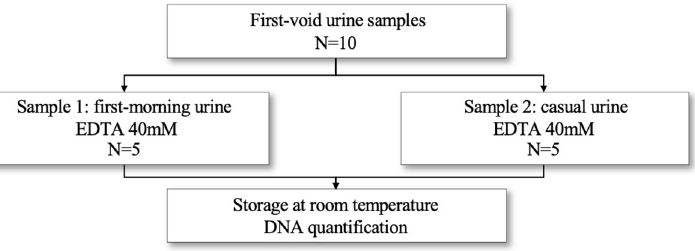
Fig 3. Overview of sample collection and processing for the third evaluation. Two samples were collected from each of the five participants, one from a first-morning micturition and a second one at a convenient time of the day which differed between women and was not prespecified. Samples were then stored at room temperature until DNA extraction 24 hours after